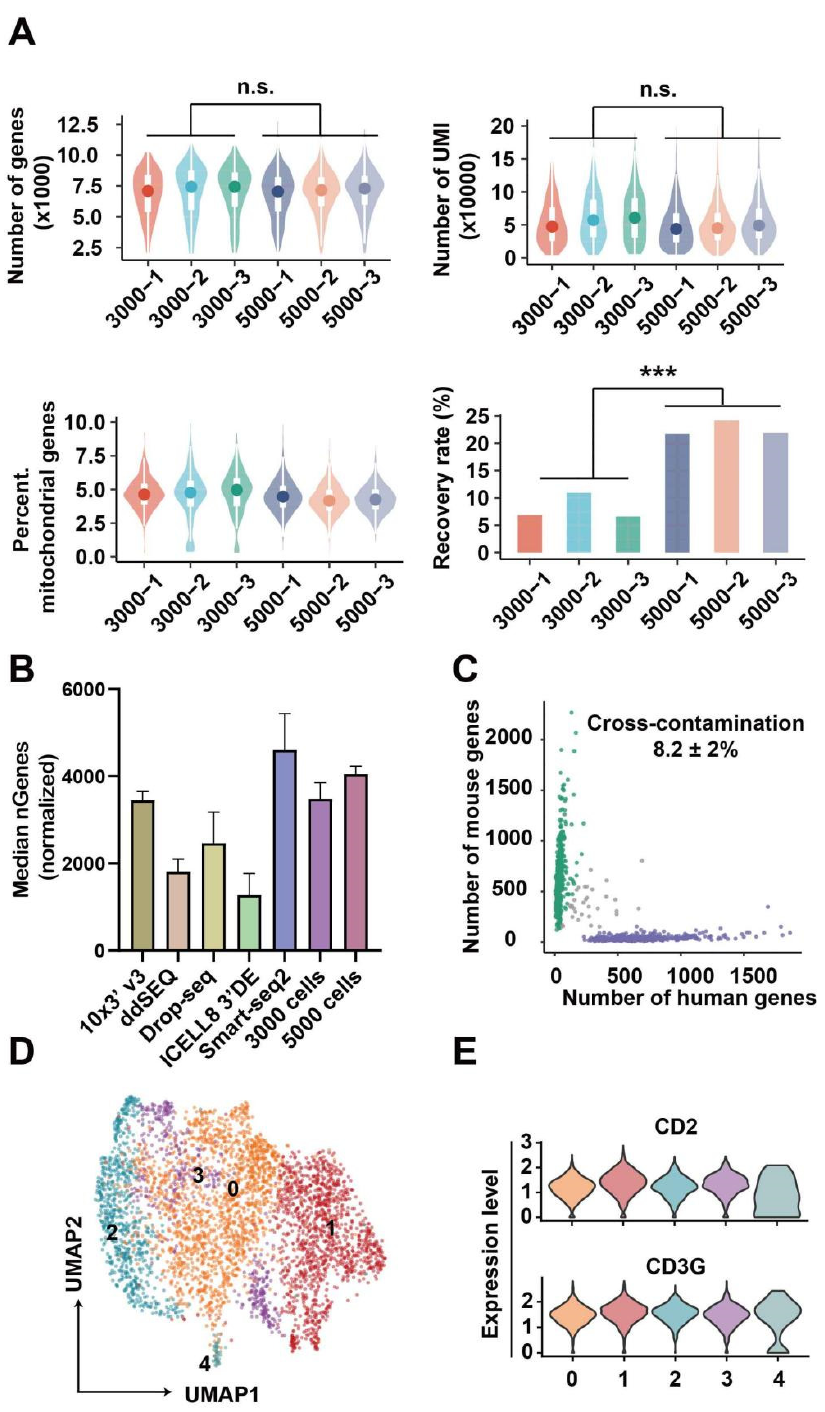
Figure 4. Quality of scRNA-seq data. ( A ) From the upper to lower, the number of genes per cell (1st), UMI per cell (2nd), and the percentage of mitochondrial genes per cell (3rd), and cell recovery rate (4th). *** represents a significant difference. ( B ) The median of genes per cell generated by other methods and our method. The gene numbers of 10X, ddSEQ, Drop-seq, ICell8 and our method were adjusted by read number to normalize sequencing depth. ( C ) The number of genes of human or mouse in each cell. ( D ) UMAP of cell clusters when SNN graph was construed with a resolution = 1. The numbers 0 to 4 represent five distinct cell subsets. ( E ) Features markers of TCR-T